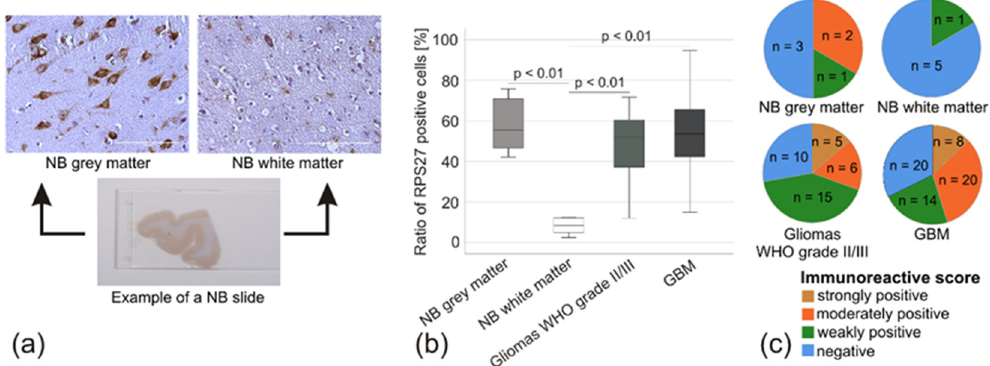
Figure 5. RPS27 protein expression estimated by immunohistochemistry. ( a ) Example of an NB slice with RPS27-DAB staining in the grey and white matter. Scale bars = 100 µm. ( b ) Percentage of RPS27-positive cells compared to all cells. p -values based on ANOVA. ( c ) Pie-diagram based on immunohistochemical score.